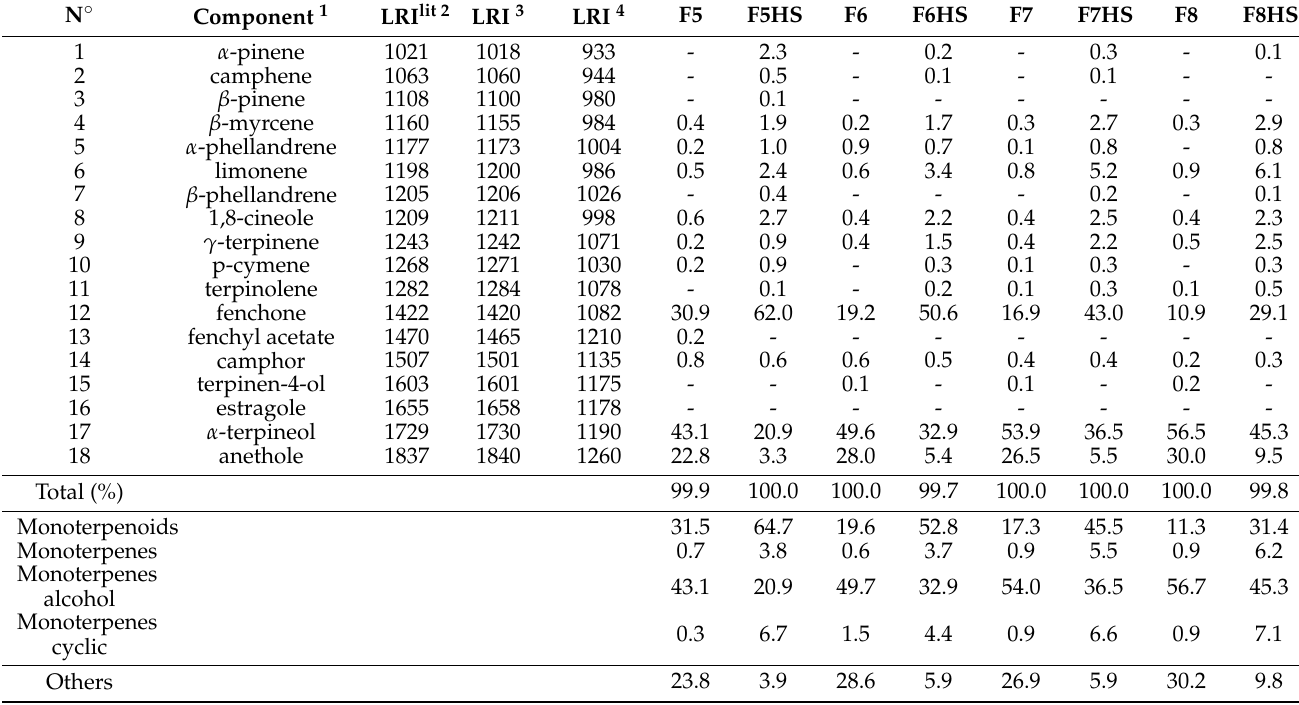
Table 3. Chemical composition (%) of FVEOs from Nikši´c analyzed by GC/MS and HS-GC/MS.